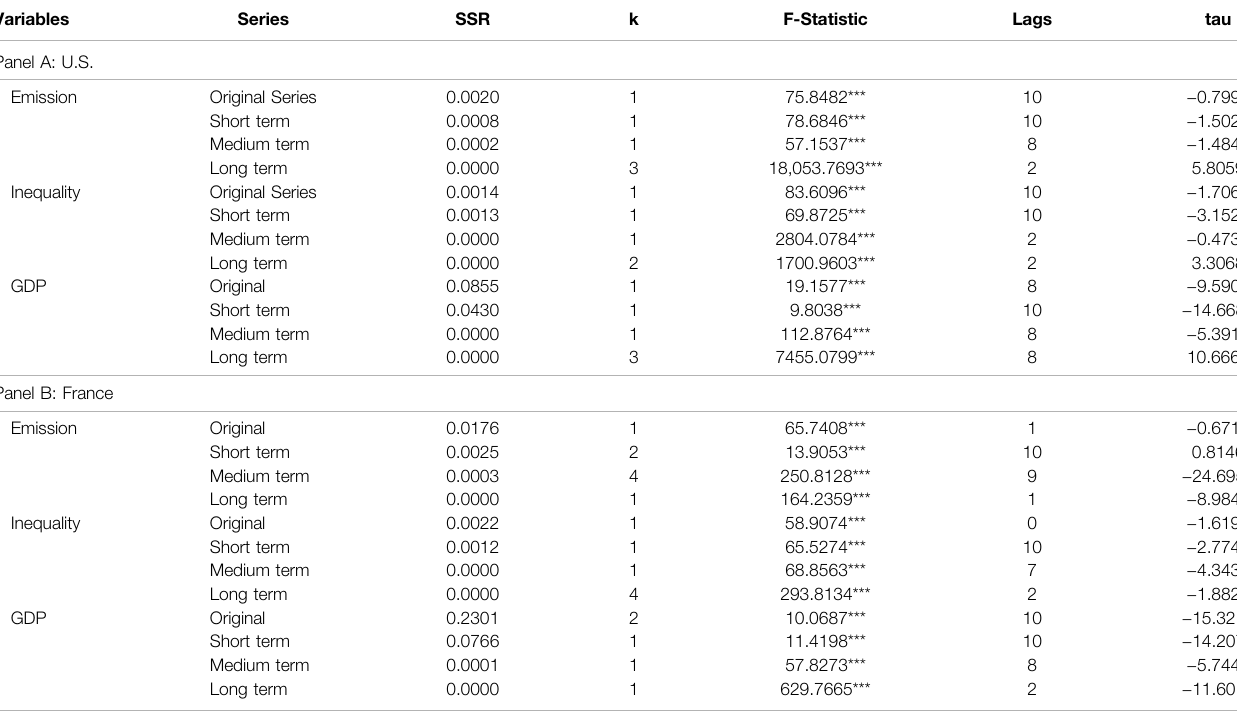
TABLE 2 | Fourier unit root test results. Variables Panel A: U.S.